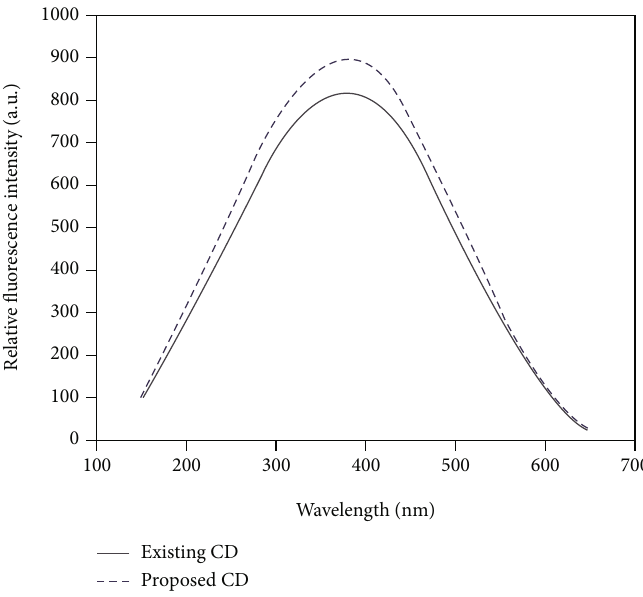
Figure 3: Plot of wavelength vs relative fl uorescence intensity.